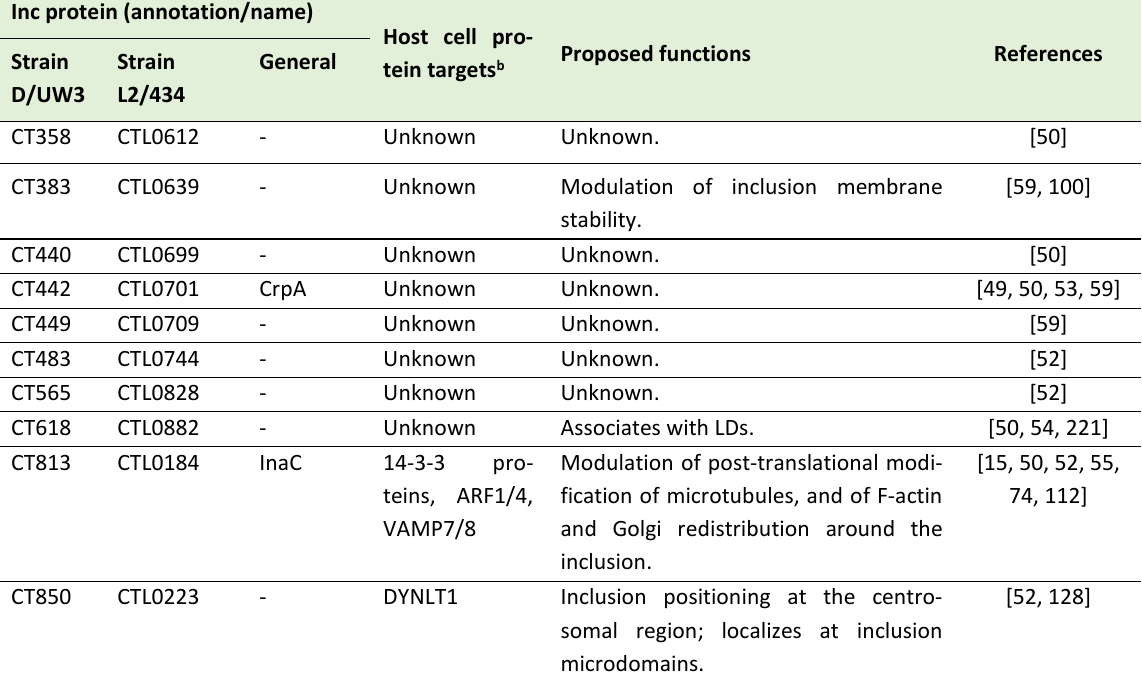
TABLE 1: C. trachomatis known Inc proteins a (continued). Inc protein